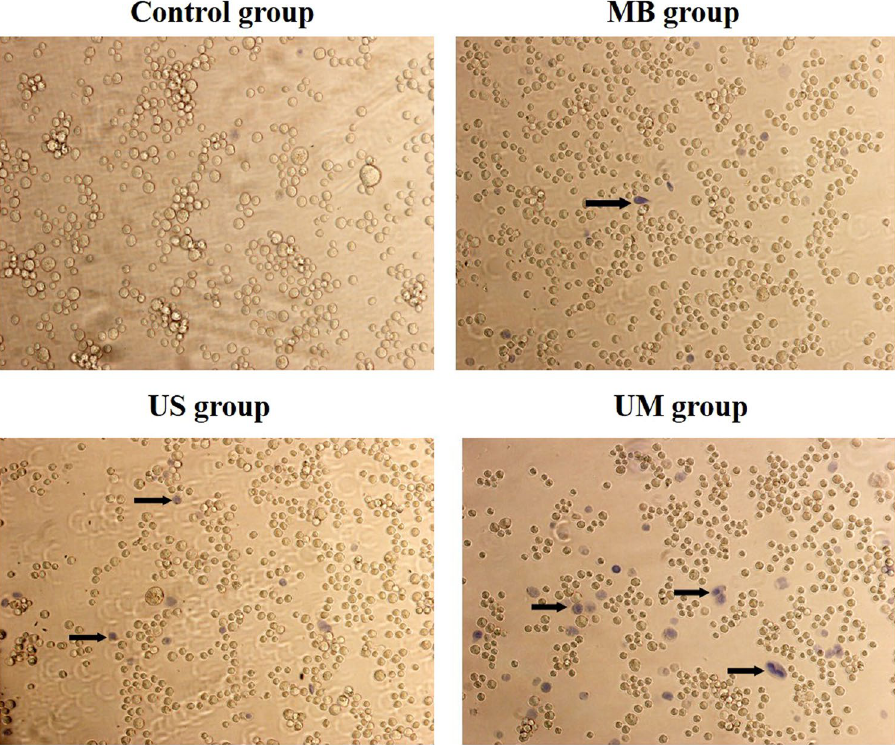
Figure 1. The proportion of membrane-damaged cells (labeled with black arrow) in the UM group was most obvious of all groups. The US group displayed a certain amount of blue-stained cells as well, whereas the control group and MB group showed scant staining ( × 200).